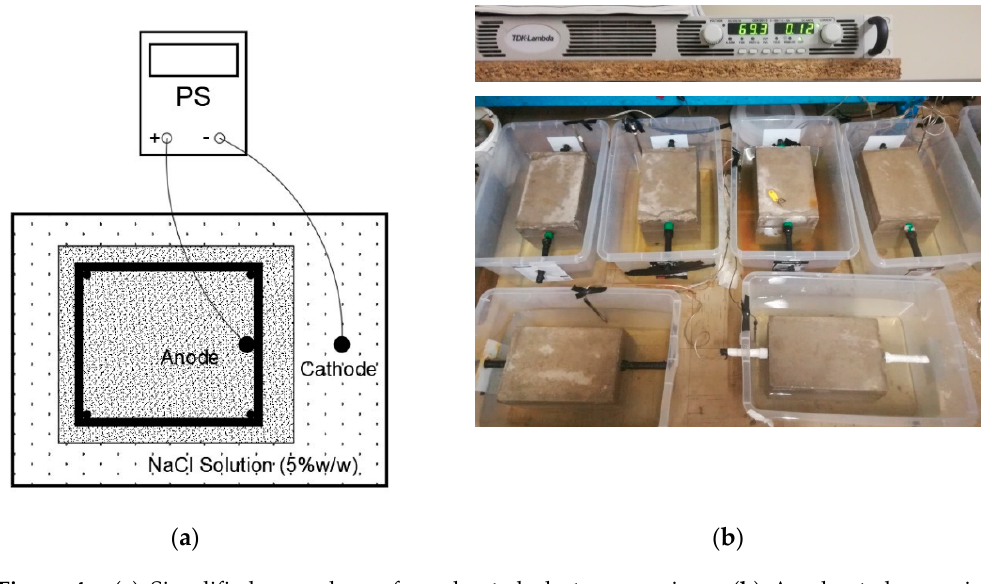
Figure 4. ( a ) Simplified procedure of accelerated electro-corrosion. ( b ) Accelerated corrosion experiments on reinforced concrete (RC) specimens via inducing